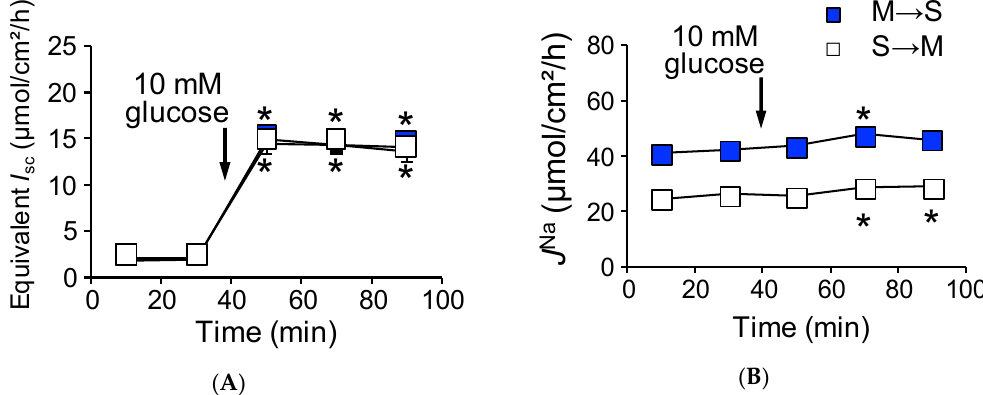
Figure 3. Open-circuit conditions attenuate glucose-induced J Na MS in wild-type mice: Glucose-induced equivalent short-circuit current changes ( A ) and 22 Na + unidirectional flux changes ( J Na ) ( B ) were measured simultaneously under open-circuit conditions. Equivalent short-circuit current was determined from transepithelial potential di ff erences and transepithelial conductance by applying Ohm’s law as described in the Materials and Methods. Where indicated by the arrows, glucose was added to the mucosal side. Each point represents means ± SE ( n = 5 and 5, M to S and S to M, respectively). Where error bars are absent, they are smaller than the symbol used. * p < 0.05 as compared with the control.